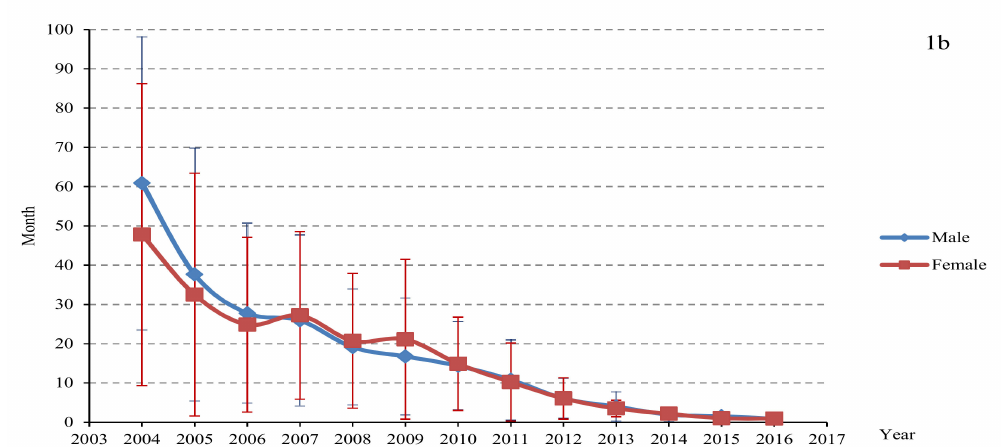
Figure 1. The CD4 counts at diagnosis ( a ) and lag time between HIV diagnosis and initial ART ( b ) by gender.